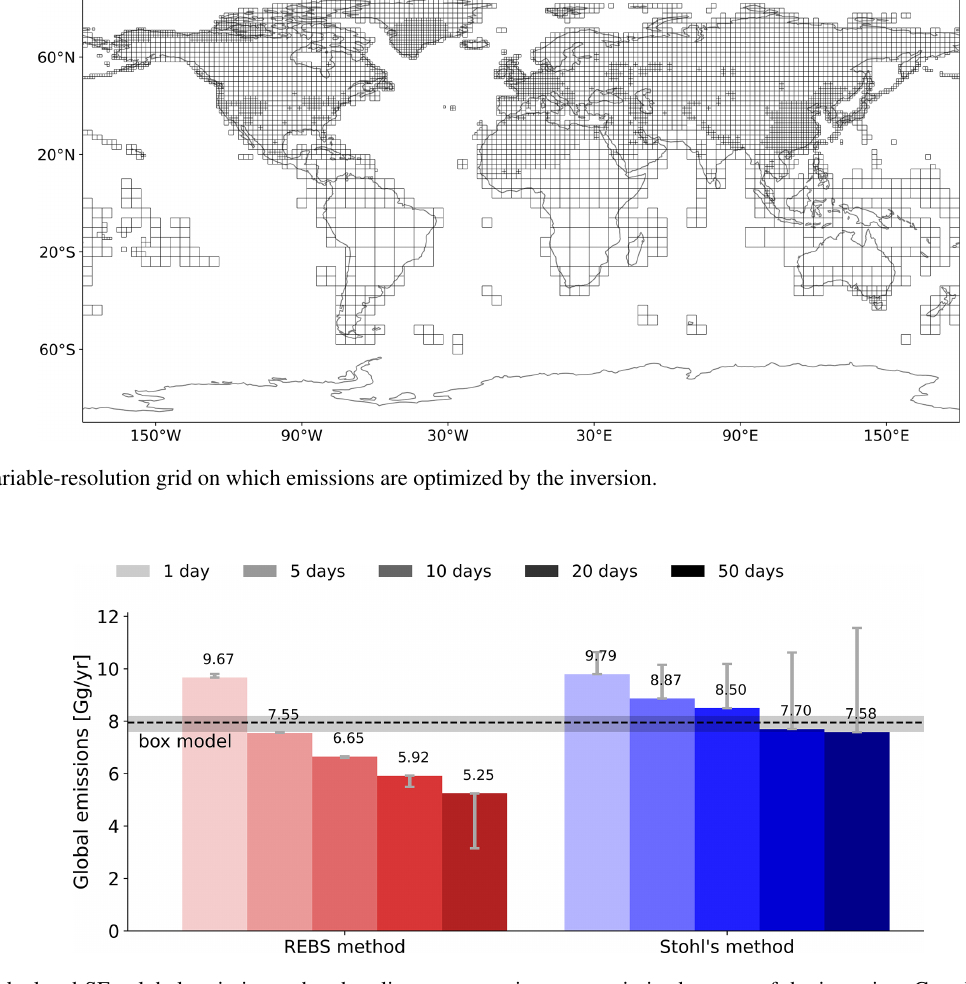
Figure A2. Calculated SF 6 global emissions when baseline concentrations are optimized as part of the inversion. Grey bars represent the improvements obtained by the baseline optimization. Results are shown for the REBS method and Stohl’s method and for all five applied simulation periods between 1 and 50d. The horizontal dashed line represents the reference value of the AGAGE 12-box model with shaded error